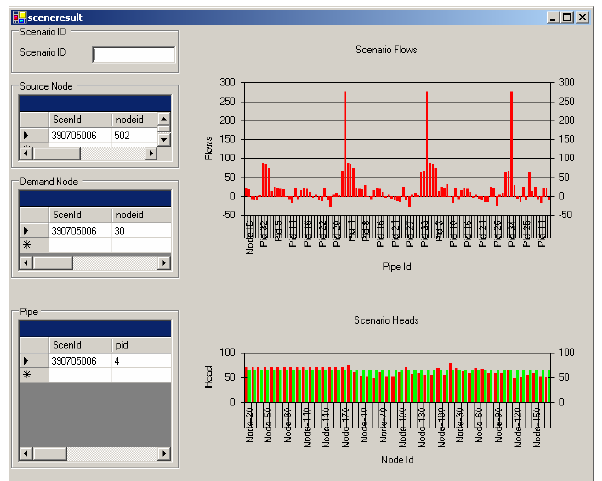
Figure 15. Scenario for problem identification and remedial mea- sures. Fig. 15. Scenario for Problem Identification and Remedial Mea- sures Fig. 15. Scenario for Problem Identification and Remedial Mea-